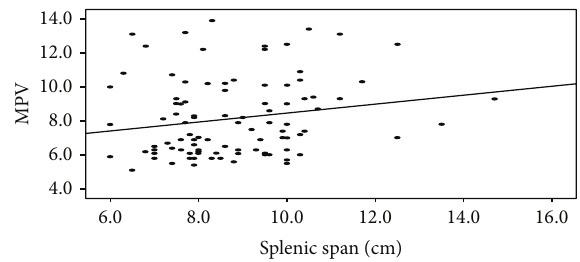
Figure 1: Correlation between MPV and